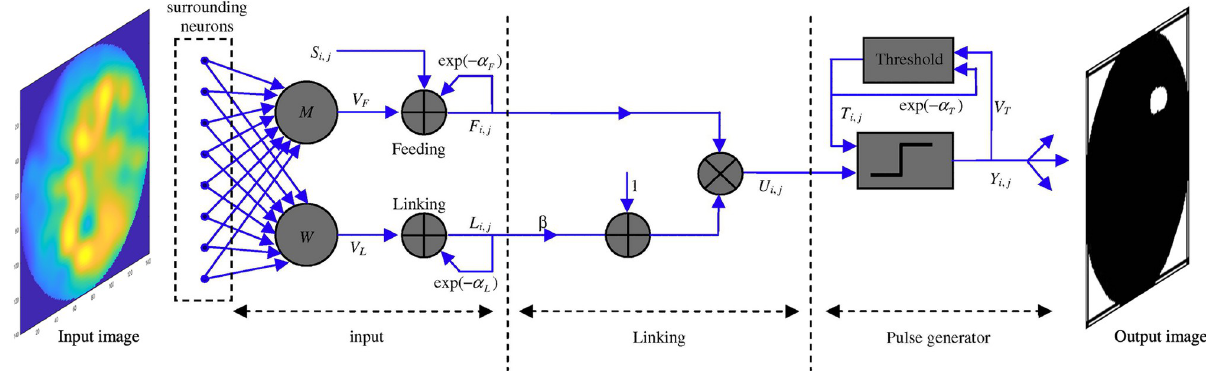
Fig 4. The flow graph of the adaptive image segmentation using PCNN